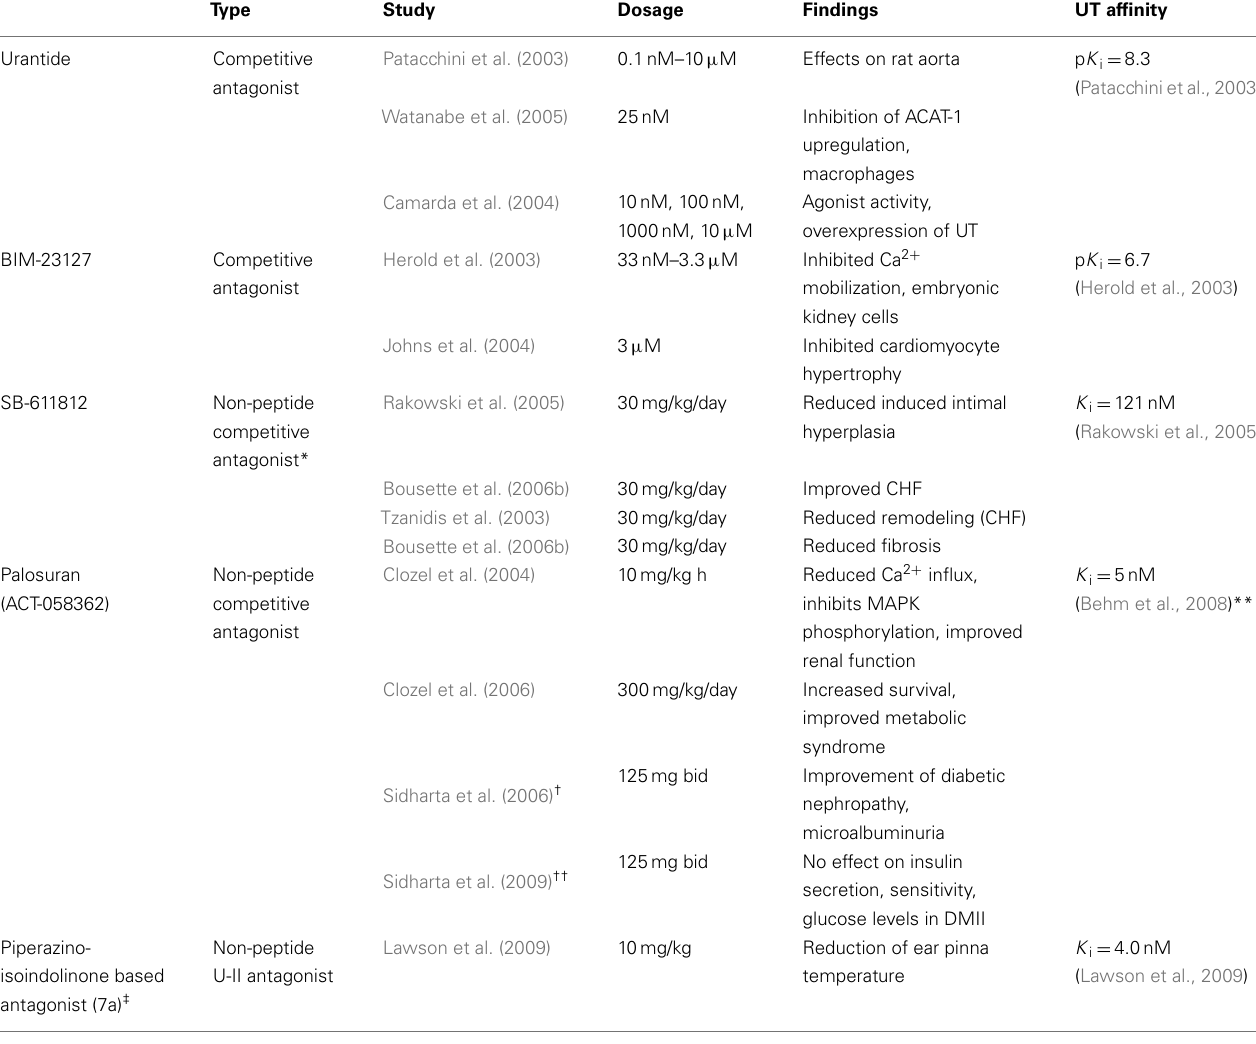
Table 1 | Clinical findings, dosages, and affinities of current UT